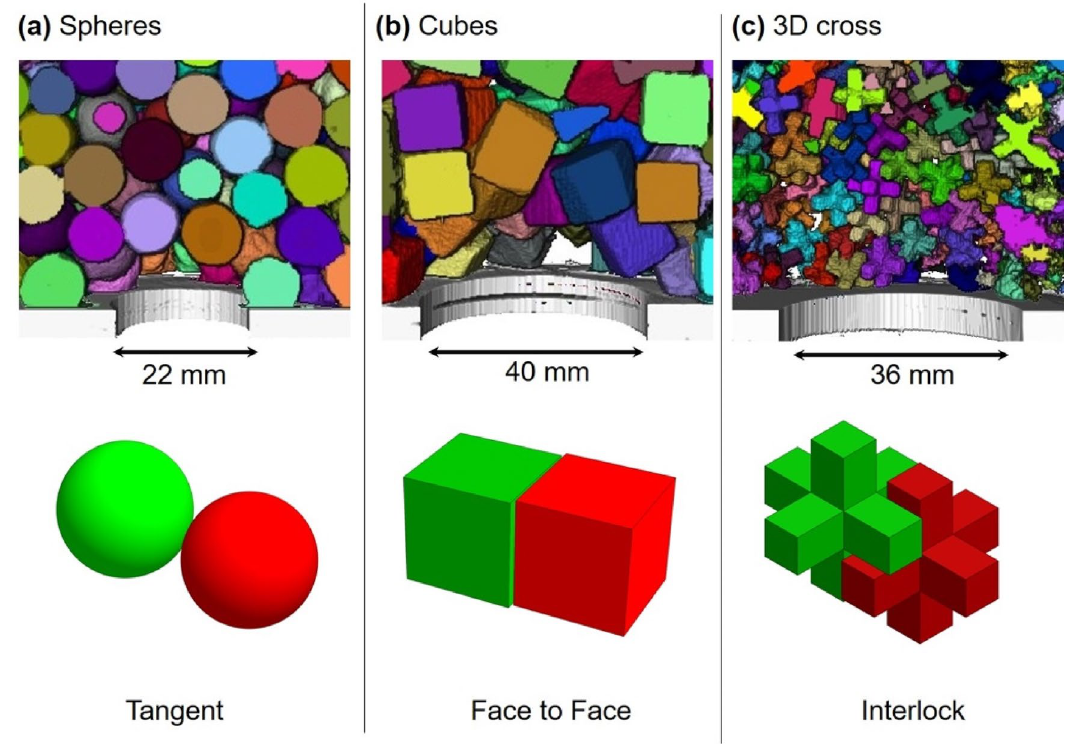
Figure 7. Bridge topology (experimental results). CT scans of bridges formed by ( a ) spheres, ( b ) cubes and ( c ) 3D crosses above the orifice during dry granular flow. Typical particle–particle interaction modes are shown below each